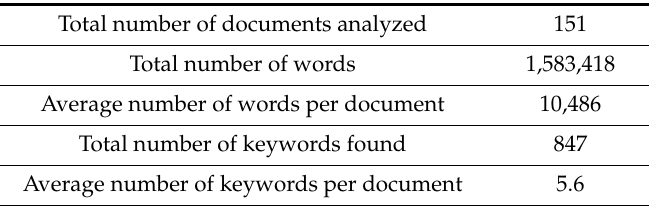
Table 1. Descriptive statistics of the keywords